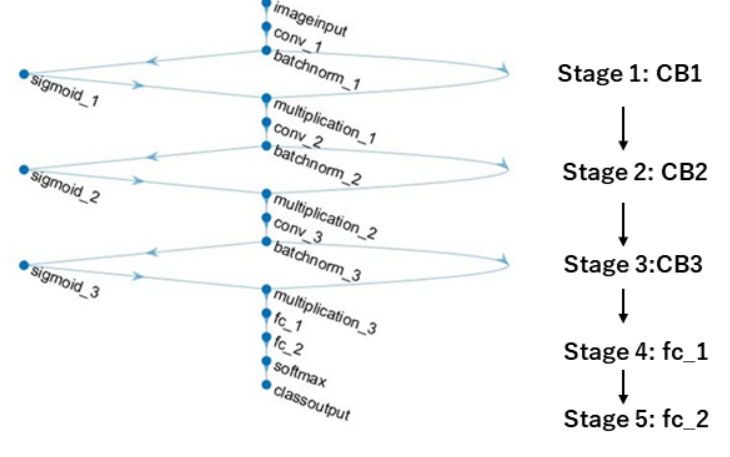
Figure 3. A new designed architecture.